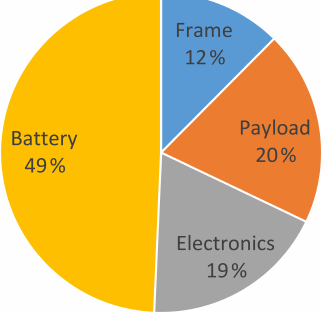
Figure 2. Weight breakdown of the drone components.